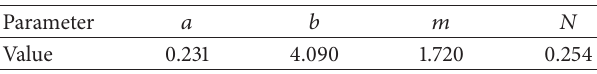
Table 3: Back-analysis results: model parameters for accumulated